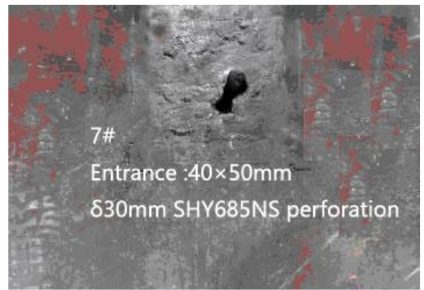
Figure 9. Damage results of witness block (7#).